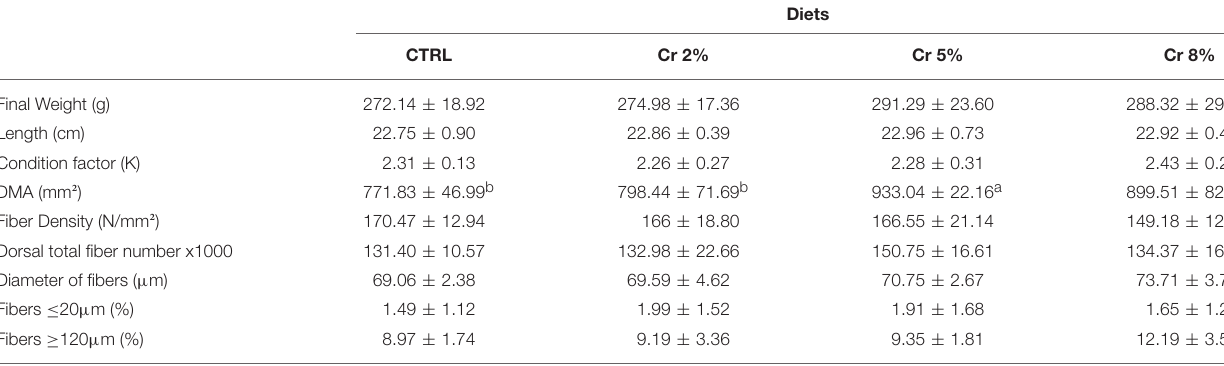
TABLE 3 | Growth performance and muscle cellularity of gilthead seabream juveniles fed CTRL, Cr 2, 5, and 8%